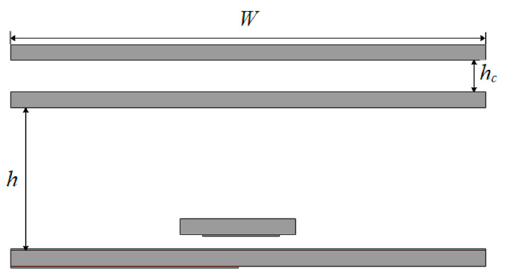
Figure 11. Schematic diagram of F-P resonant cavity antenna.